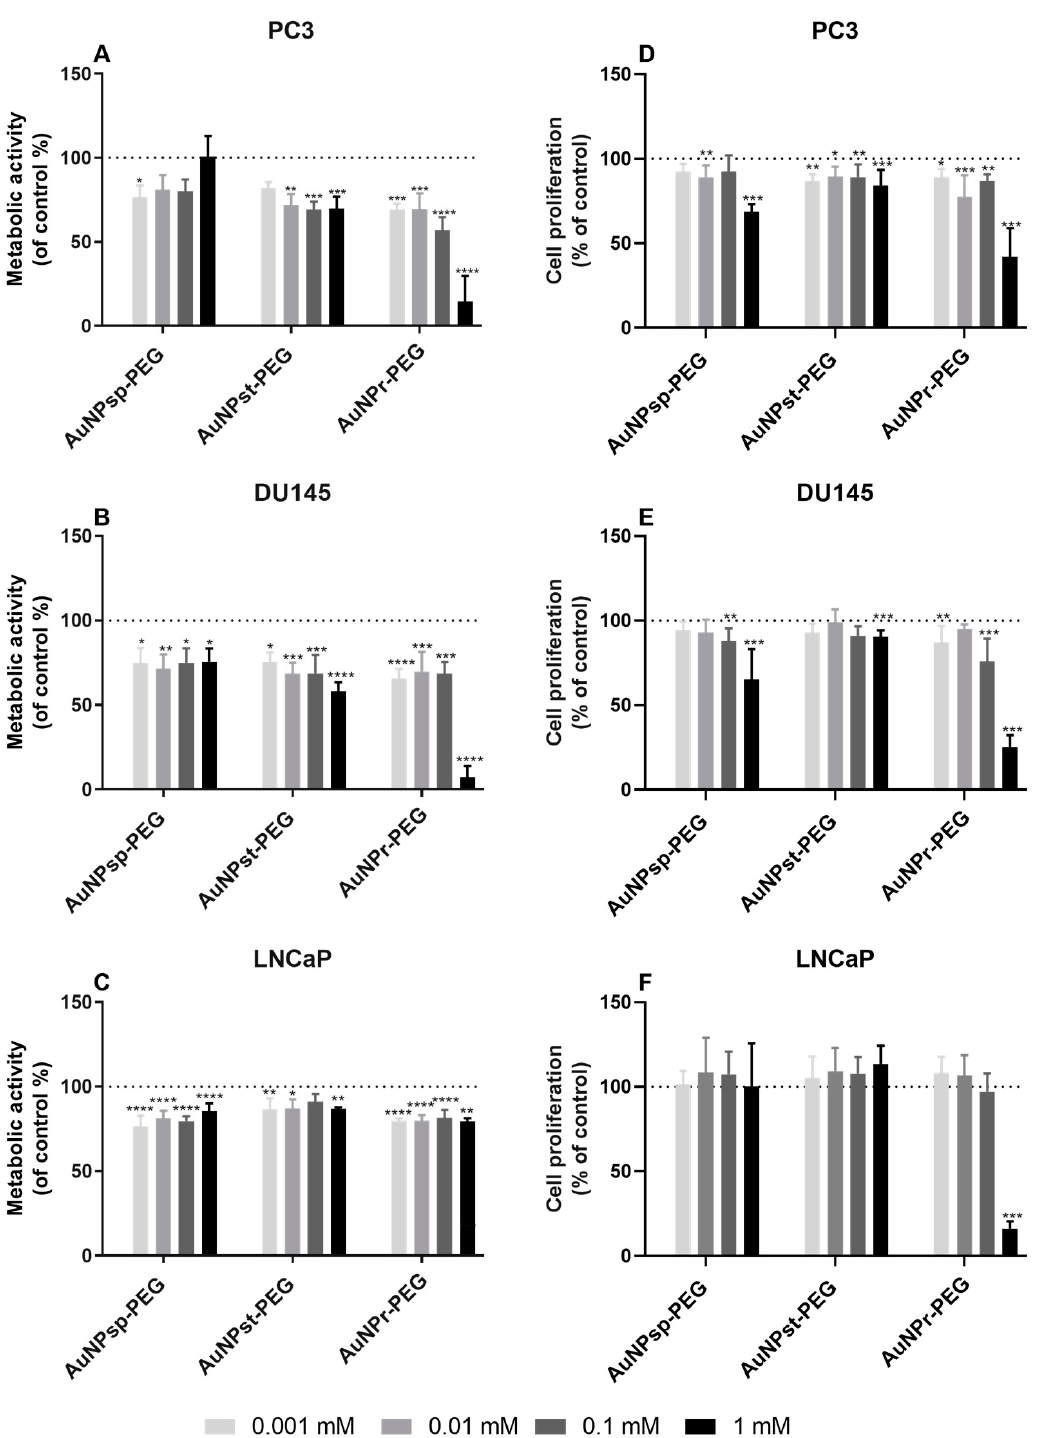
Figure 5. Metabolic activity in PC3 cell line ( A ); DU145 cell line ( B ), and LNCaP ( C ) cell lines. The proliferation of PC3 cell line ( D ); DU145 cell line ( E ), and LNCaP cell line( F ). ( A – F ) Cells were treated with AuNP sp -PEG, AuNP st -PEG and AuNP r -PEG at 0.001, 0.01, 0.1, and 1 mM concentration for 24 h. The results were expressed as a percentage of the control (cells without treatment). Results were presented as mean ± standard deviation; n = 9. Statistical significance was considered as (*) p < 0.05, (**) p < 0.01, (***) p < 0.001, and (****) p < 0.0001 when compared to the control.